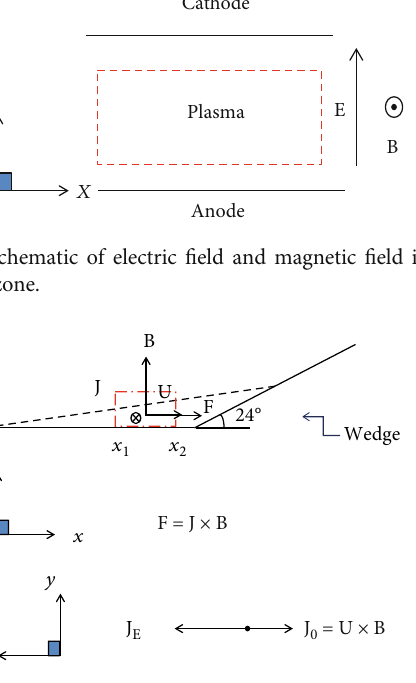
Figure 8: Schematic sketch of MHD separation fl ow control over a 24-degree ramp. Table 4: Electromagnetic fl ow control parameters on SWBLI.